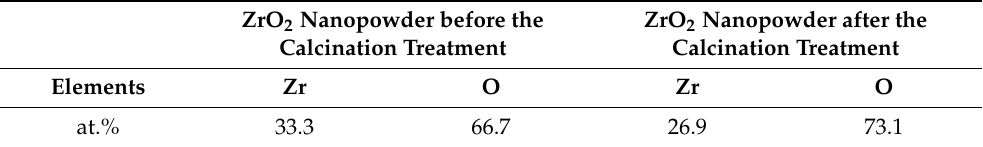
Table 1. EDS point analysis of the ZrO 2 nanopowders before and after the calcination treatment at 800 ◦ C for 15